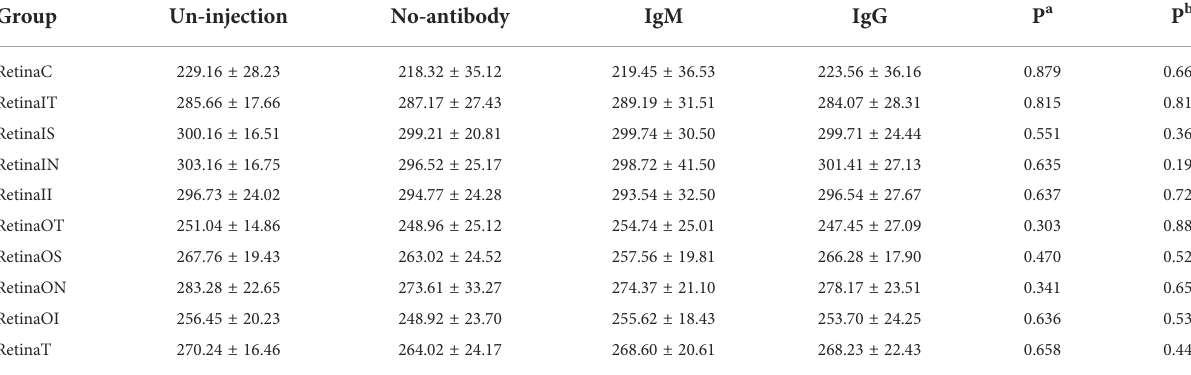
TABLE 3 Analysis of retinal thickness in the age-related cataract patients with different COVID-19 antibody statues (median ± IQR, m m). Group Un-injection